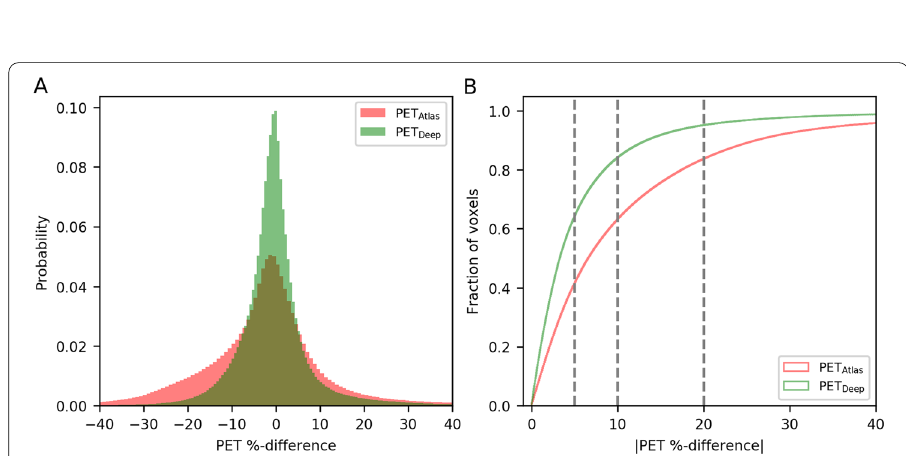
Fig. 2 Joint histograms of PET voxels within the patient volumes for ( A ) PET Deep and PET CT ( R 2 ( B ) PET Atlas and PET CT ( R 2 0.975). Notice, that the axes are clamped to SUV of 5 even though there are higher = values in the PET images